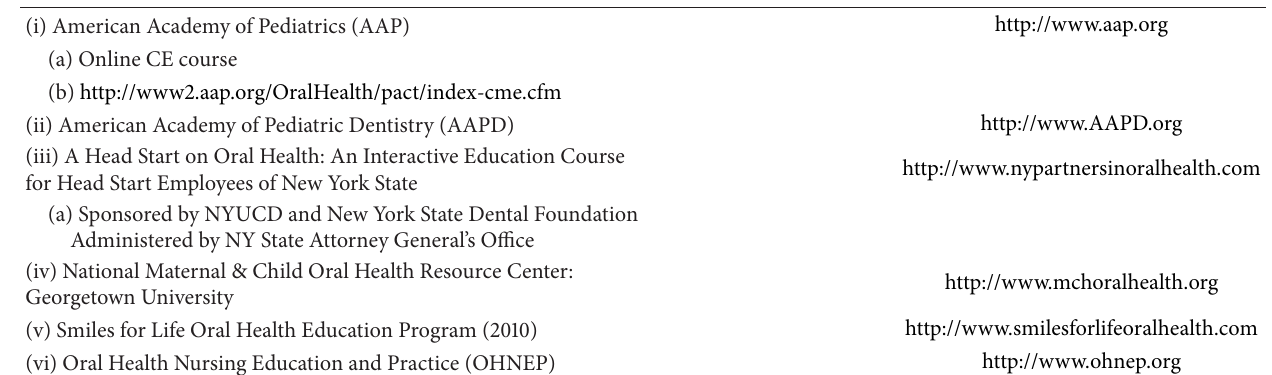
Table 4: Oral health educational resources.